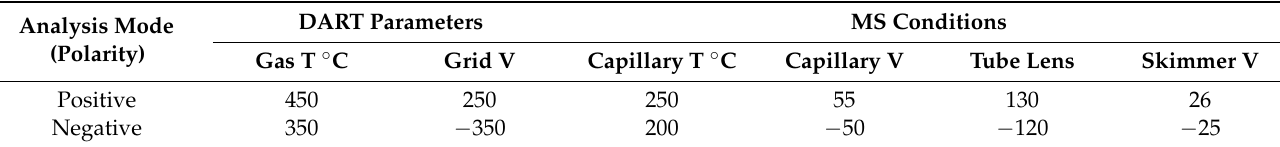
Table 1. DART parameters and HRMS conditions for untargeted analysis of pure and adulterated (with safflower and turmeric) saffron